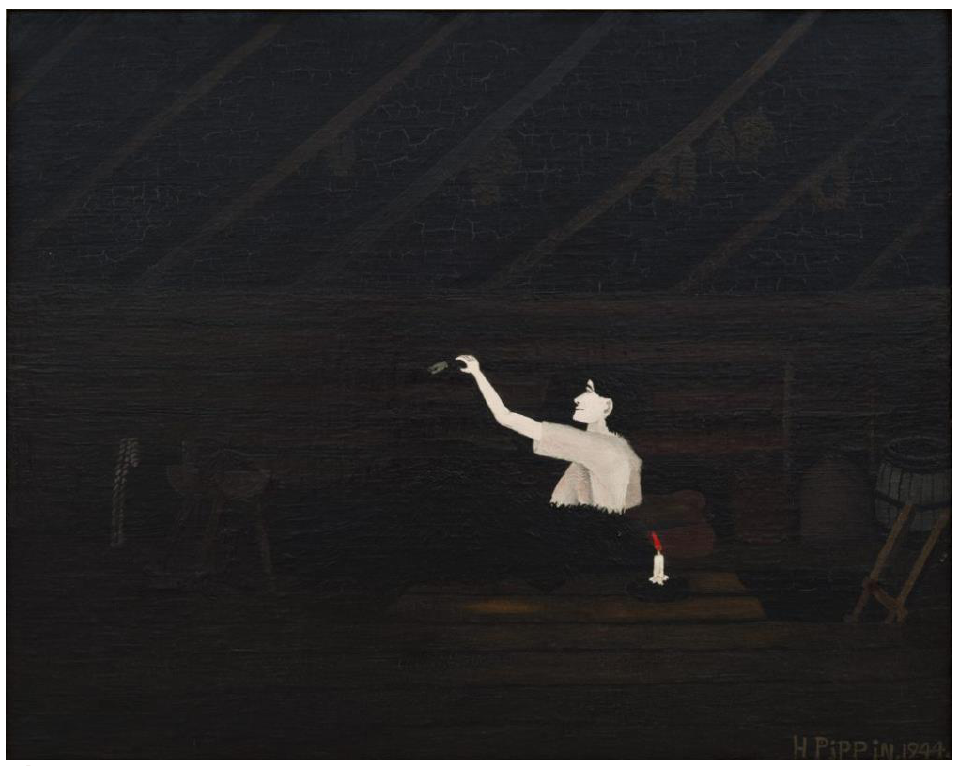
Horace Pippin, “Abe Lincoln’s First Book,” 1944, oil on canvas, Collection of the Carnegie Museum of Art, Gift of Sara M. Winokur and James L. Winokur. Leading with a painting of a white president (albeit by a black artist) and extolling U.S. patriotism contradicts the commonsense understanding that part of the “shared urgency” surrounding 20/20 was ushered in by widespread black-led opposition to state violence in the form of police brutality. Black Lives Matter has wrought an overdue awareness of the histories of quotidian and juridical antiblackness in the United States, including in museums. Borrowing a phrase from the U.S. Constitution to title the o pening section, “A More Perfect Union,” risked